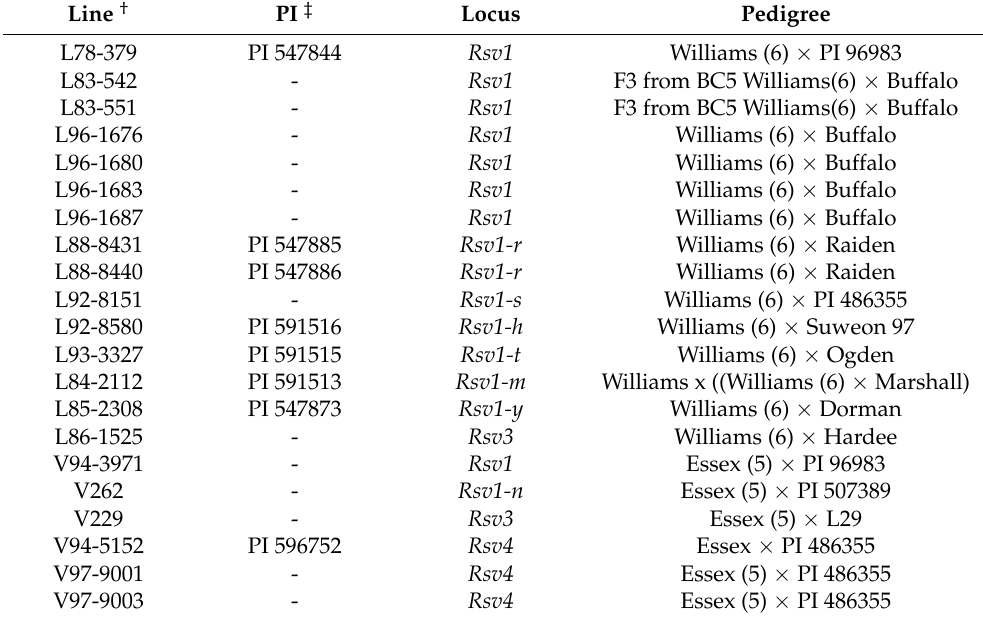
Table 5. Williams and Essex near isogenic soybean lines carrying different SMV resistance